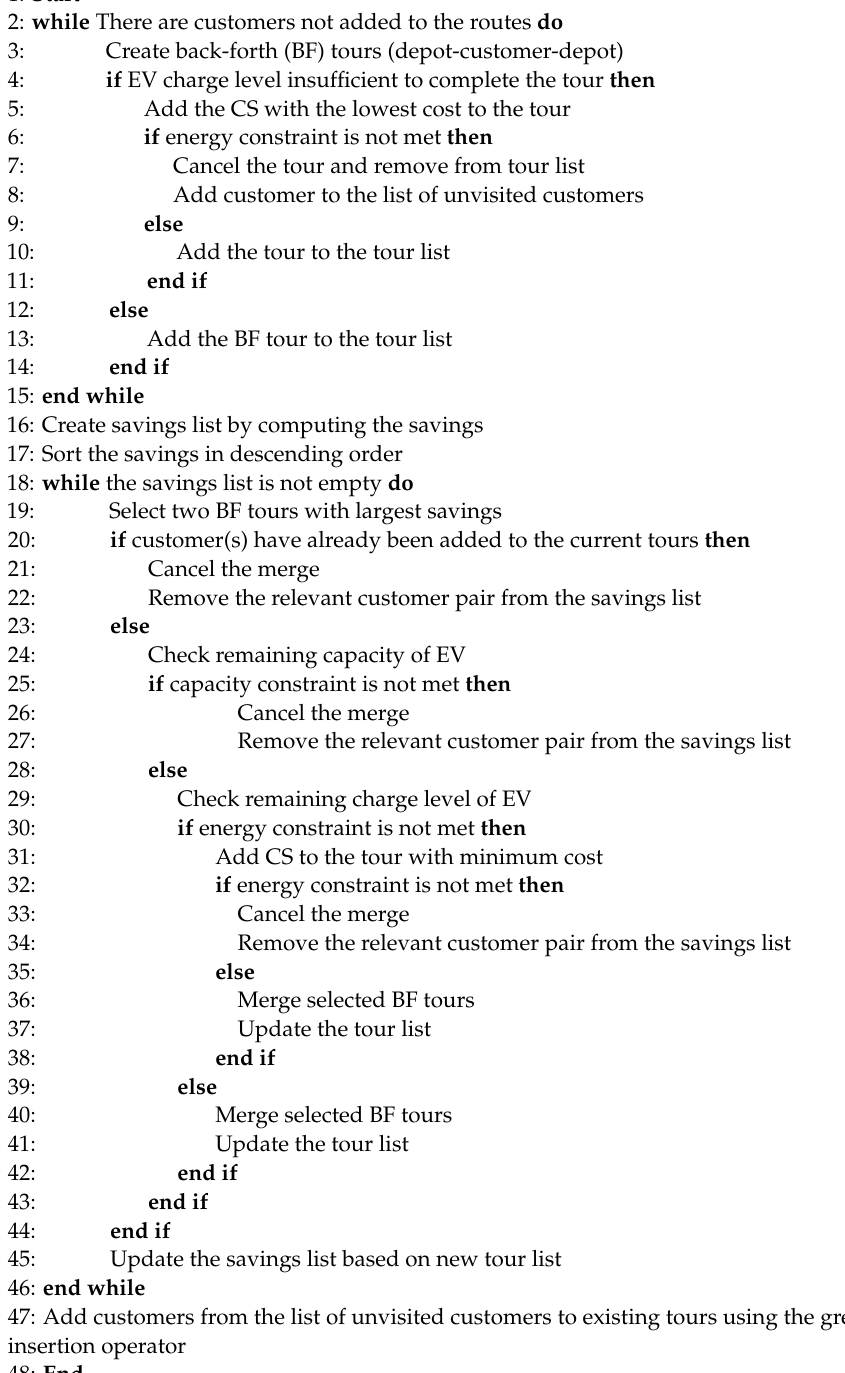
Algorithm 1 Modified CW Savings Algorithm for